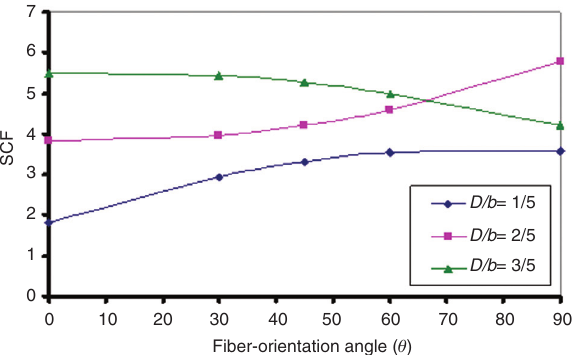
Figure 5 Effect of fiber orientation angle ( θ ) on SCF for a / b = 1.0 using graphite/epoxy material.